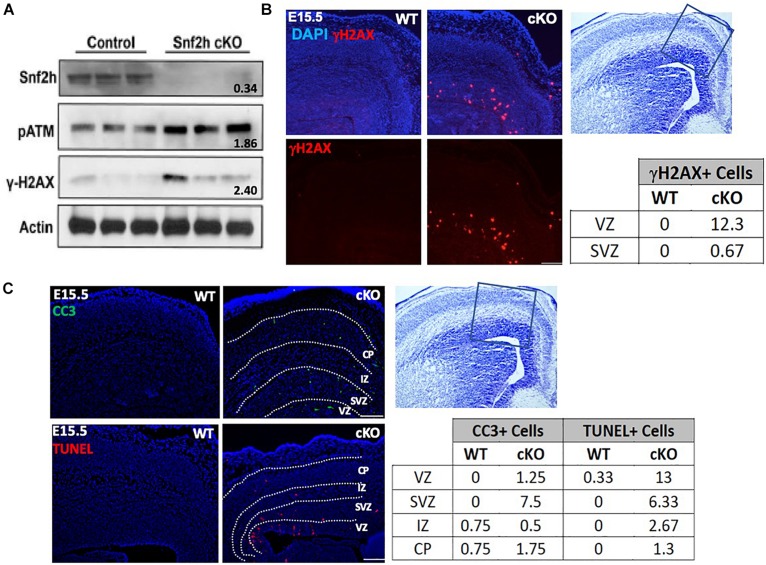
Cell loss is associated with an activated DNA damage response. (A) Immunoblots from E15.5 cortical extracts demonstrate increased levels of phosphorylated-ATM (pATM) protein and γ-H2AX in Snf2h cKO mice. Actin was used as loading control. Values denote averaged pixel densitometry normalized to Actin and relative to control samples, n = 3 mice per genotype. (B) Representative images in the developing neocortex from mutant and control mice of γ-H2AX+ cells (red) at E15.5. Sections were counterstained with DAPI (blue). Table shows the average number of γ-H2AX+ cells within the VZ and SVZ (n = 3 mice per genotype). (C) Representative images in the developing neocortex from mutant and control mice of cleaved caspase 3+ (CC3; top) and TUNEL+ (bottom) cells at E15.5. Dotted lines demarcate VZ (ventricular zone), SVZ (subventricular zone), IZ (intermediate zone), and CP (cortical plate). Cresyl violet stained section on the right panel shows the approximate location of epifluorescent images. The average number of CC3+ and TUNEL+ cells for each cortical region is shown in the table (bottom right; n = 3 mice per genotype). Scale bars, 100 μm.